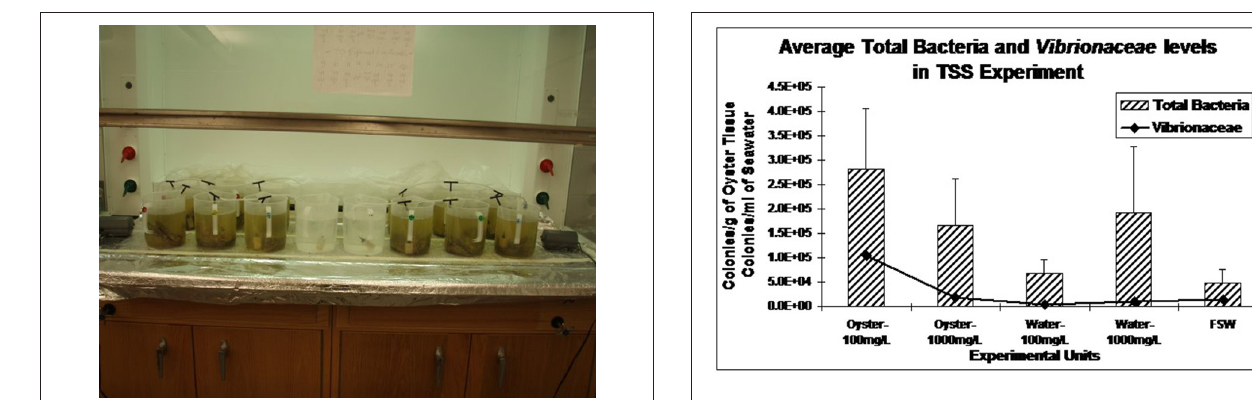
and aerated to keep the dissolved oxygen levels above 5 mg/L.